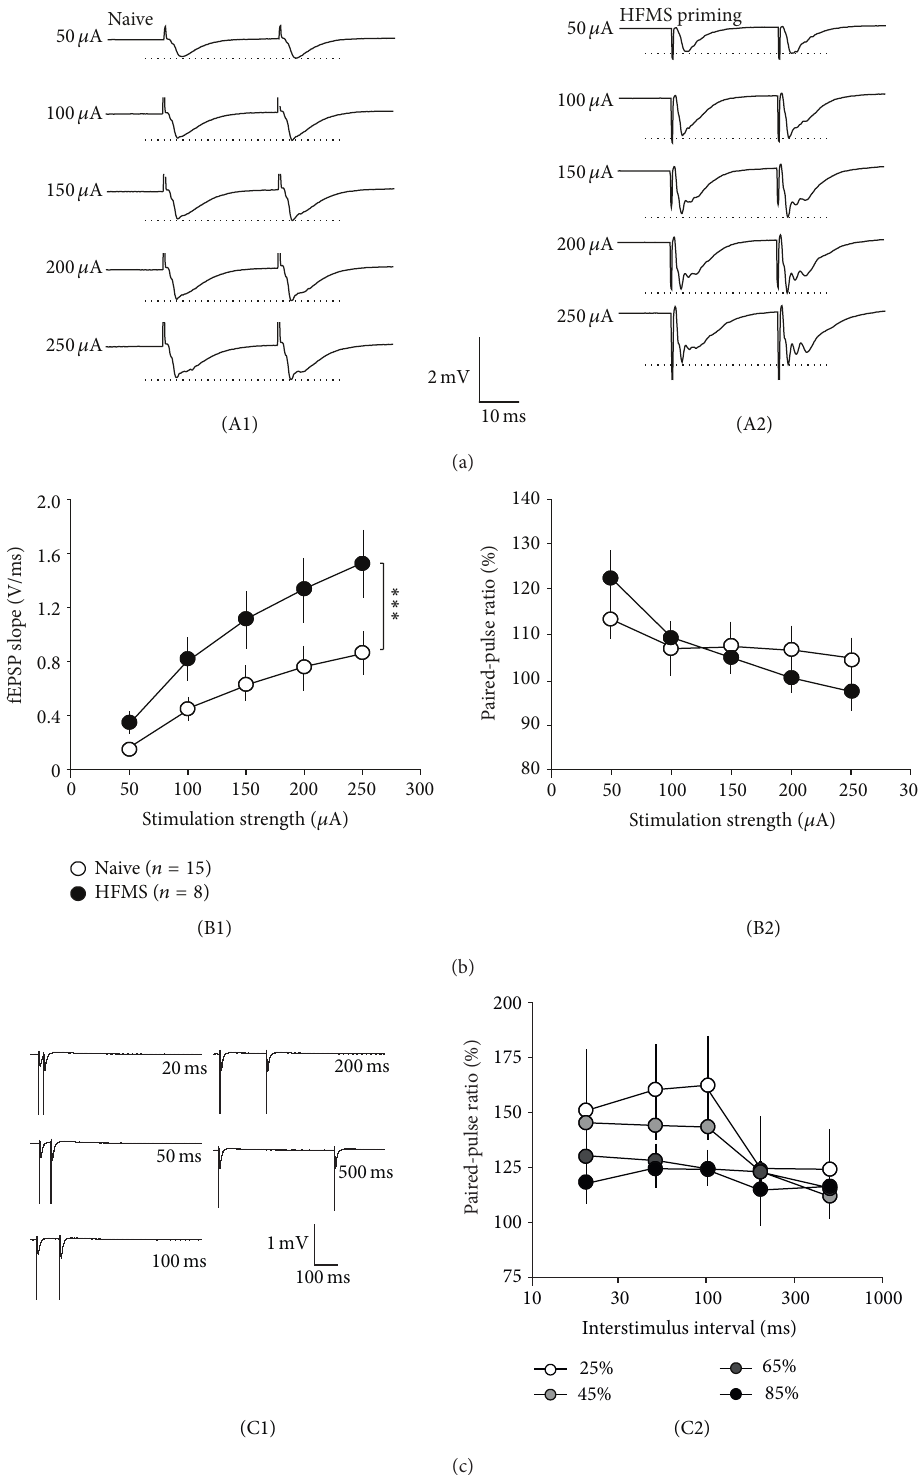
Figure 2: (a) Sample traces (interstimulus interval 40 ms) at increasing stimulation strengths (50–250 𝜇 A) of naive (A1) and HFMS-primed slices (A2). Note the difference in amplitude between both representative recordings. (B1) Input-output curve of naive and HFMS-primed slices were significantly different. (B2) The paired-pulse ratio dropped significantly with increasing stimulation strength but was not different between naive and HFMS-primed slices. (C1) Sample traces of paired-pulse recordings at increasing interstimulus intervals (20–500 ms), obtained by stimulation strength adjusted to yield 45% of maximal fEPSP amplitude. (C2) The paired-pulse ratio is a function of stimulation intensity. The stimulation strength was adjusted to achieve 25%, 45%, 65%, or 85% of the maximal fEPSP